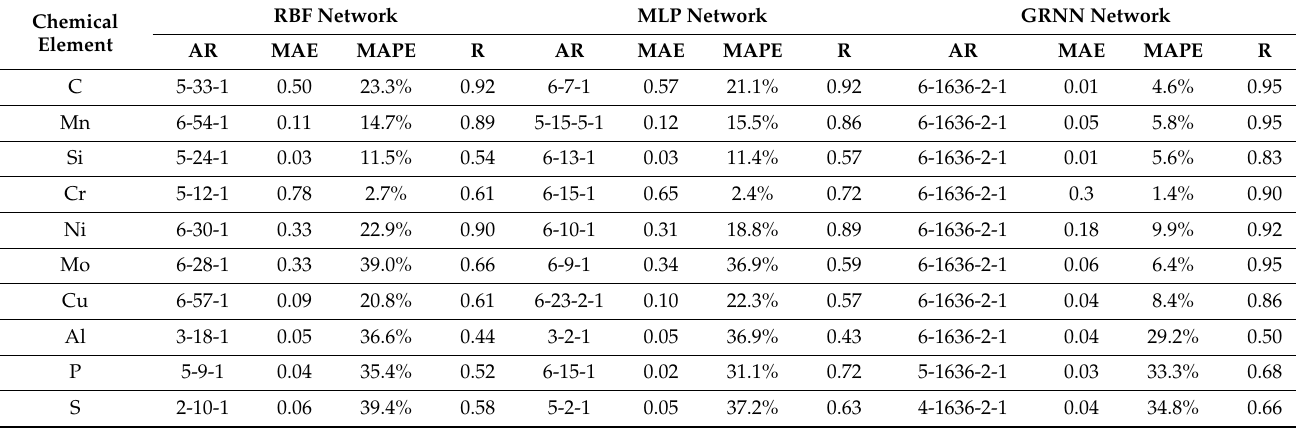
Table 2. Architecture and regression parameters of developed artificial neural networks (testing set). Chemical Element